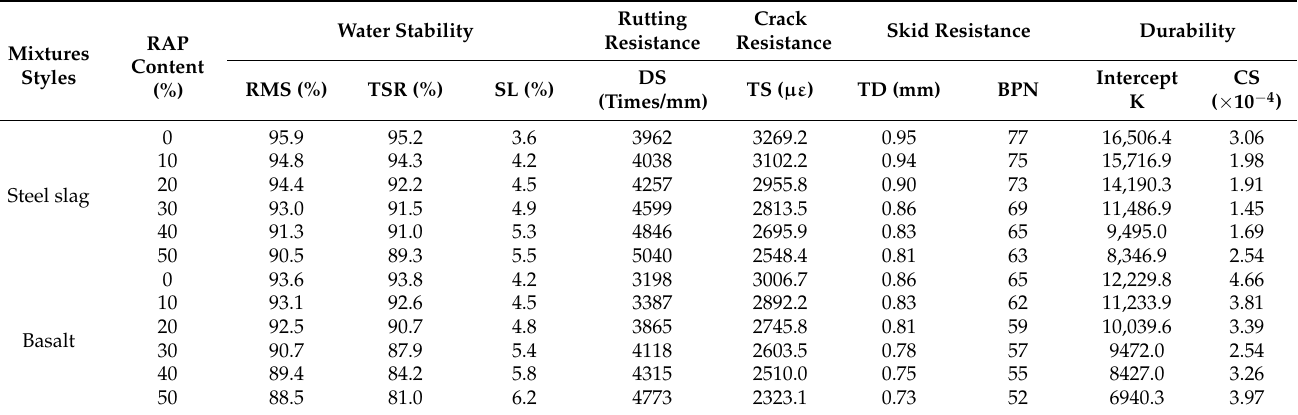
Table 6. Evaluation indicators of RAM with different RAP